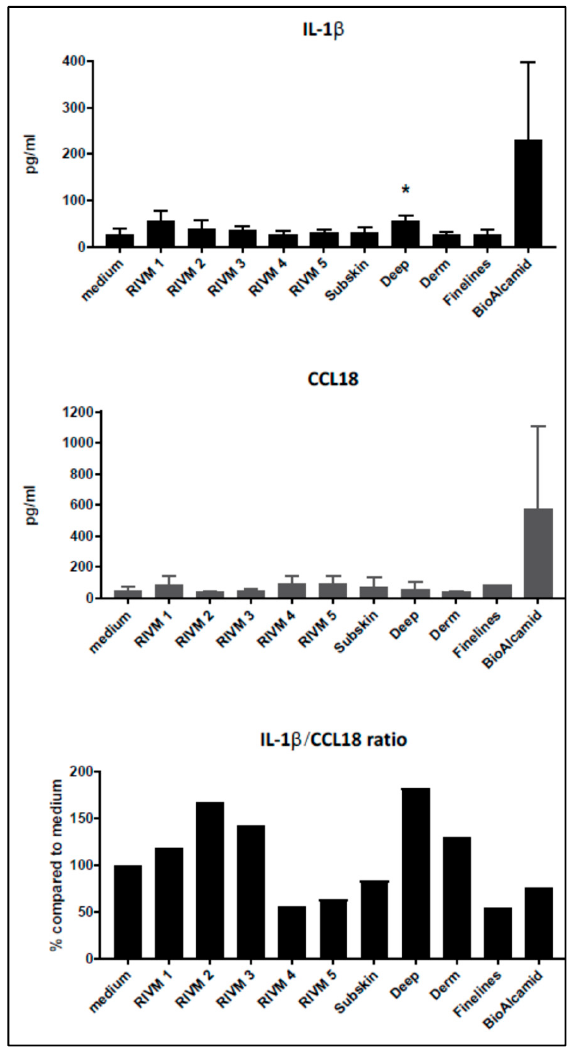
Figure 2. Effect of RIVM and Perfectha ® (Subskin, Deep, Derm, Finelines) HA fillers and Bio- Alcamid ® non-resorbable filler on cytokine production by THP-1 cells. Results are presented as mean ± SD of three independent experiments while in each experiment, incubations were performed in four-fold. IL-1 β and CCL18 induction in M0 macrophages derived from monocytic THP-1 cells after exposure to extracts of RIVM preparations and commercial Perfectha ® HA fillers and of the non-resorbable filler Bio-Alcamid ® . RIVM preparations #1–#5 have an increase in cross-linking of HA chains by BDDE from #1 to #5. Perfectha ® fillers have a decrease in particle size from Perfectha ® SubSkin to Perfectha ® FineLines. * p < 0.05. Student’s t -test .